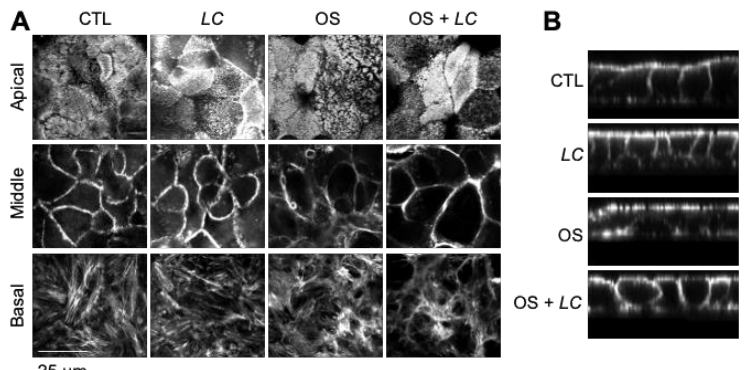
Figure 2. L. casei prevents osmotic stress-induced remodeling of the actin cytoskeleton and dissoci- ation of junctional proteins. ( A ) Caco-2 cell monolayers (13 days post-seeding) preincubated with or without L. casei (LC; 10 5 cells/mL) for 30 min, followed by osmotic stress (OS) by incubation in the hyperosmotic medium; control (CTL) monolayers received similar treatments in the iso-osmotic medium. After one hour of OS, cell monolayers were fixed and stained for F-actin using AlexaFluor- 488-labeled phalloidin. Confocal fluorescence images from 2 µm optical sections at the apical, middle, and basal regions of cells are presented. ( B ) Z-section images showing the differential distribution of actin cytoskeleton at different levels of the epithelium.